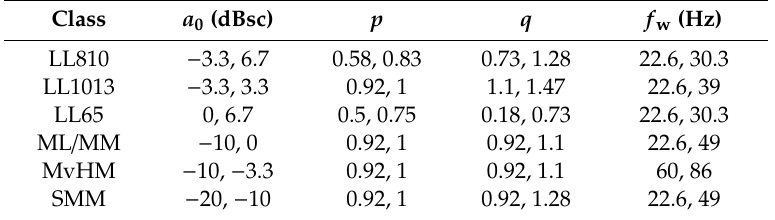
Table A3. Classes assigned by 4D peak-finding algorithm listed in Reference [24].